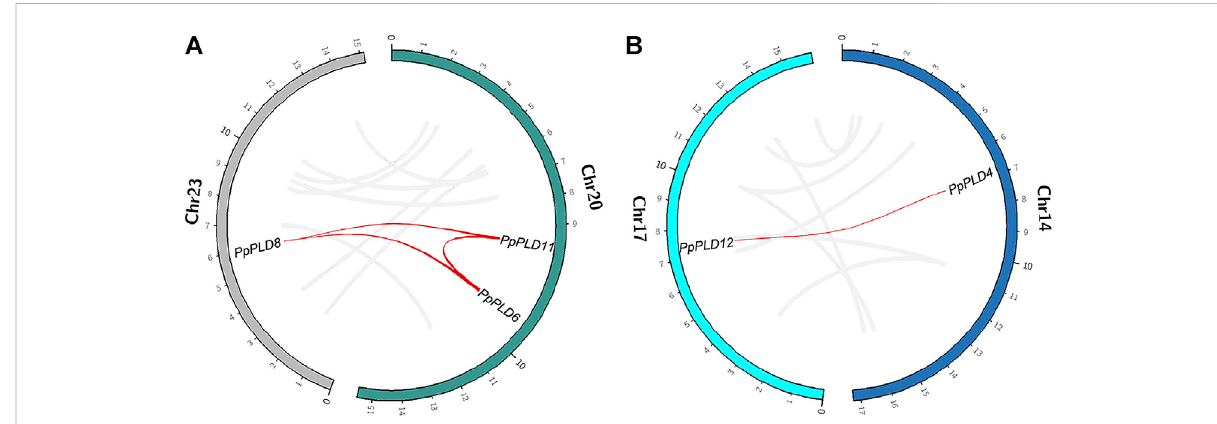
FIGURE 2 Genomic location of species-speci fi c duplicated PLDs in P. patens . (A) . PLDs 6 , 8 , and 11 . (B) . PLDs 4 and 12 . Gray lines indicate synteny blocks, and red lines indicate species-speci fi c PLD